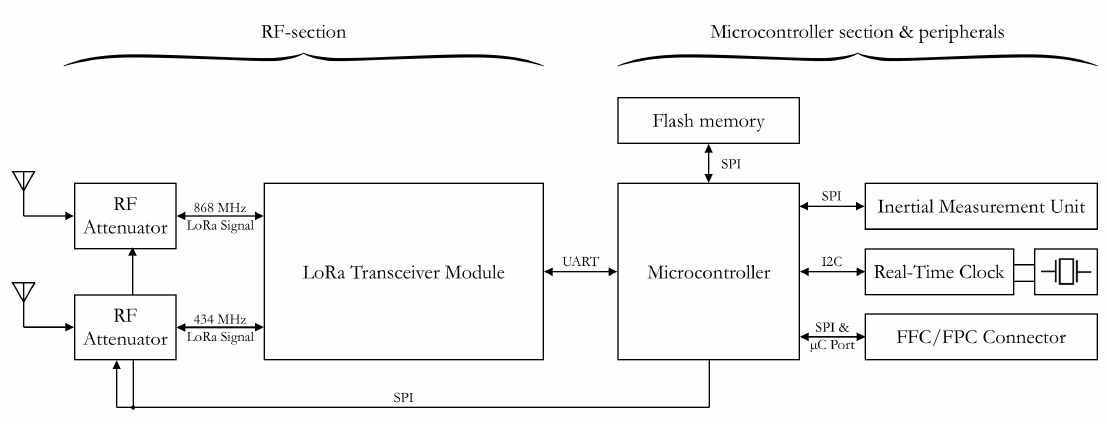
Figure 1. Block diagram of the wireless sensor